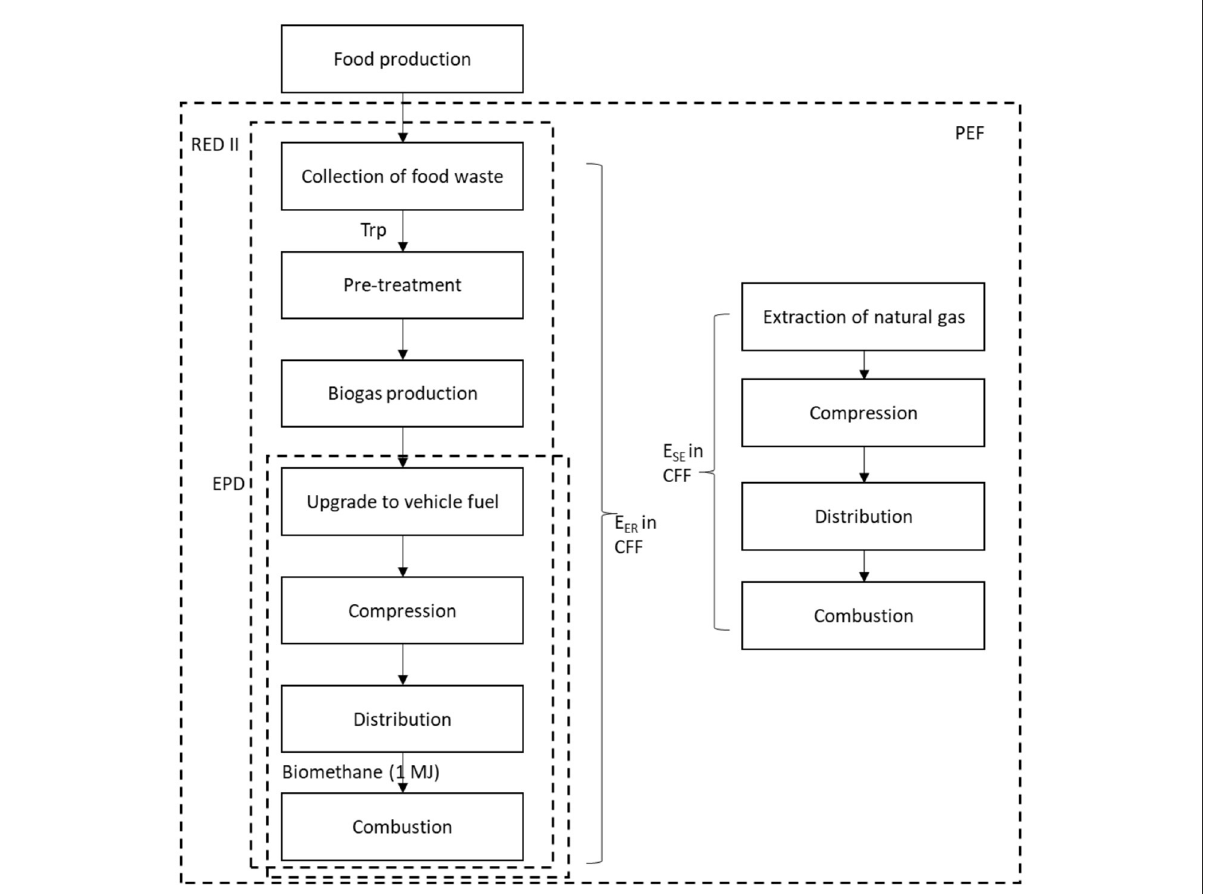
FIGURE5 System boundaries in relation to the approaches applied; RED II, PEF, and EPD. CO 2 emissions from combustion are excluded in RED II, while non-CO 2 GHGs (i.e., CH 4 and N 2 O) are included. An alternative interpretation of the CFF excludes the combustion and possibly the distribution from E ER and E SE